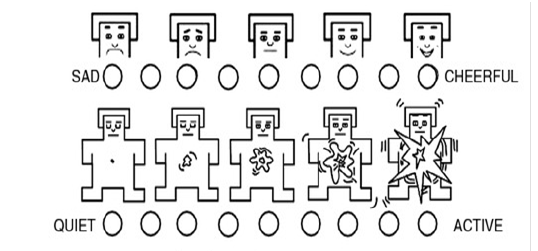
Figure 3. The Self Assessment Manikin (SAM) for valence-arousal